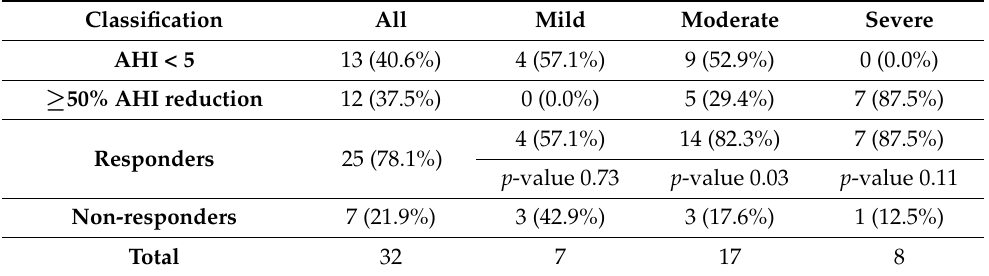
Table 3. Patients defined as responders, based on the definitions (AHI < 5/h and ≥ 50% reduction from baseline) or non-responders considering severity at